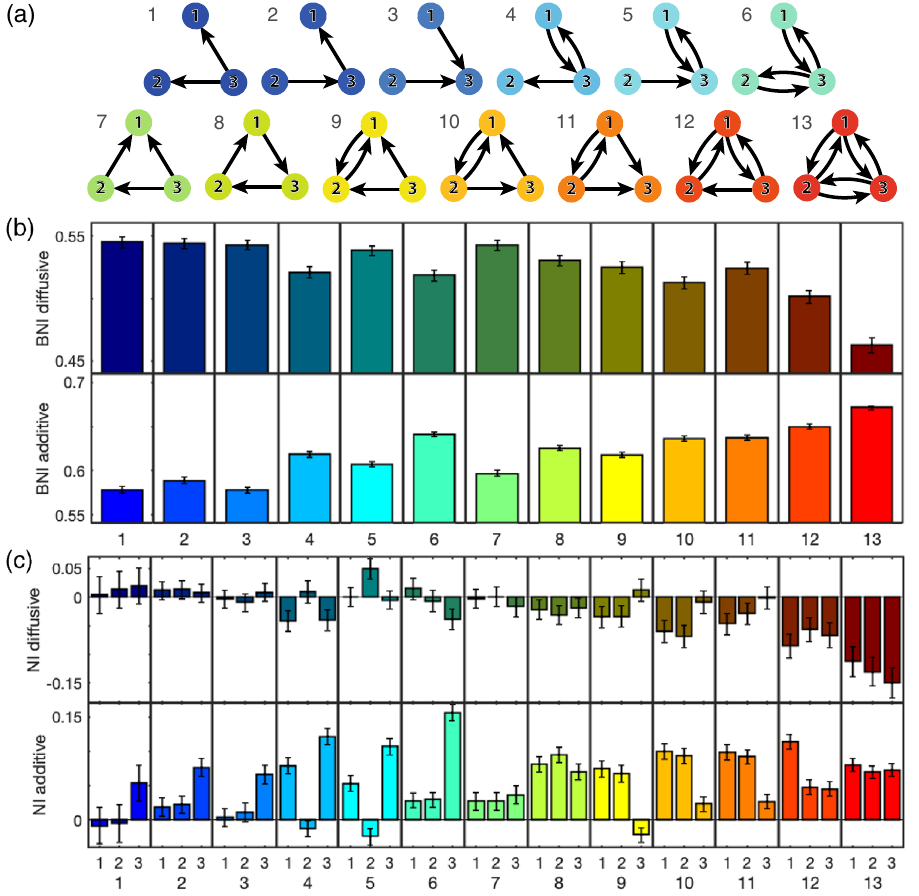
Figure 3. BNI and NI of all three-node networks for additive and diffusive couplings. Panel ( a ) shows the coupling structure for all 13 non-isomorphic three-node networks. Panel ( b ) shows the BNI for each network with either diffusive (top row) or additive coupling (bottom row). Panel ( c ) shows the NI for each node (1–3) of each network (1–13) with either diffusive (top row) or additive (bottom row) coupling. The NI distributions were computed using as BNI pre the BNI values in panel ( b ). We used β = 0.1 for the diffusive coupling, γ = 0.1 for the additive coupling, and α = 0.03 for both couplings. Standard error bars are computed over 1000 noise